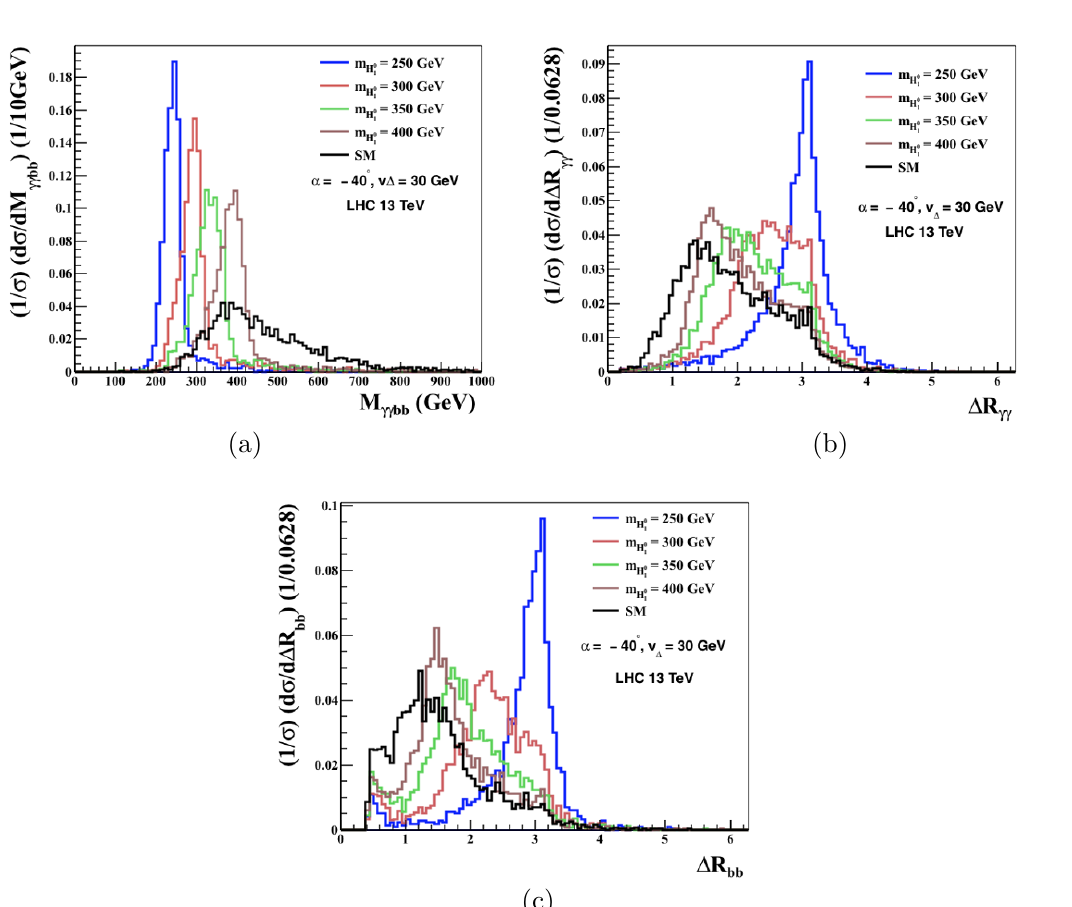
Figure 5 . Kinematic distributions of the bb(cid:13)(cid:13) channel for (a) the invariant mass M (cid:13)(cid:13)bb , (b) the opening angle (cid:1) R (cid:13)(cid:13) and (c) the opening angle (cid:1) R bb for benchmark point E with di(cid:11)erent m comparison with the SM expectations at the 13-TeV